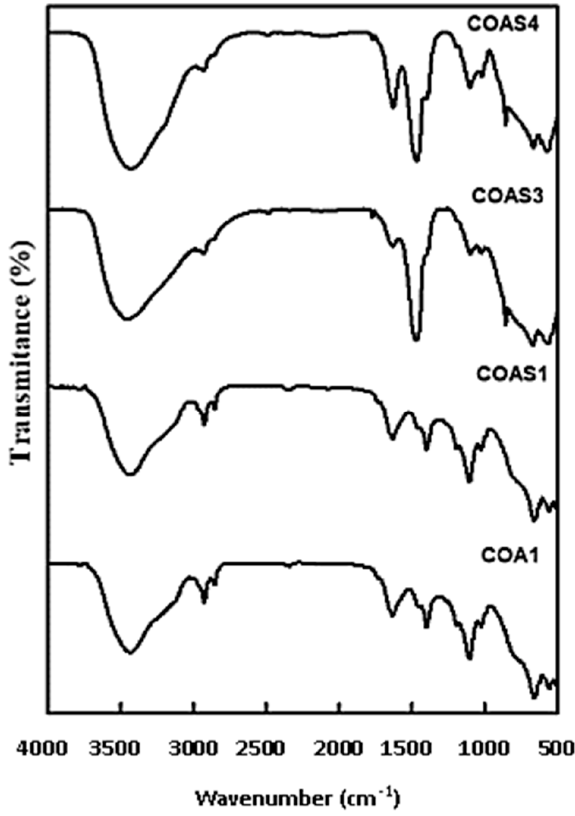
Figure 6. FT-IR spectra of Sr-doped CoAl 2 O 4